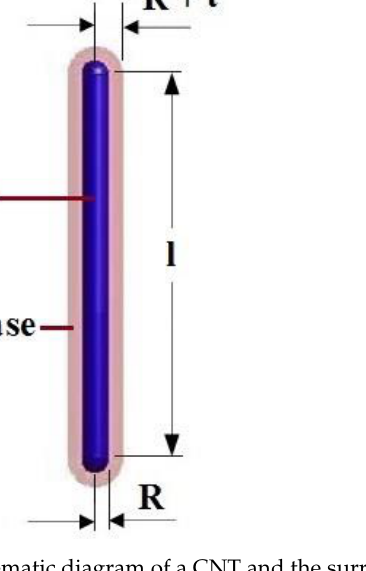
Figure 1. Schematic diagram of a CNT and the surrounding interphase in systems.